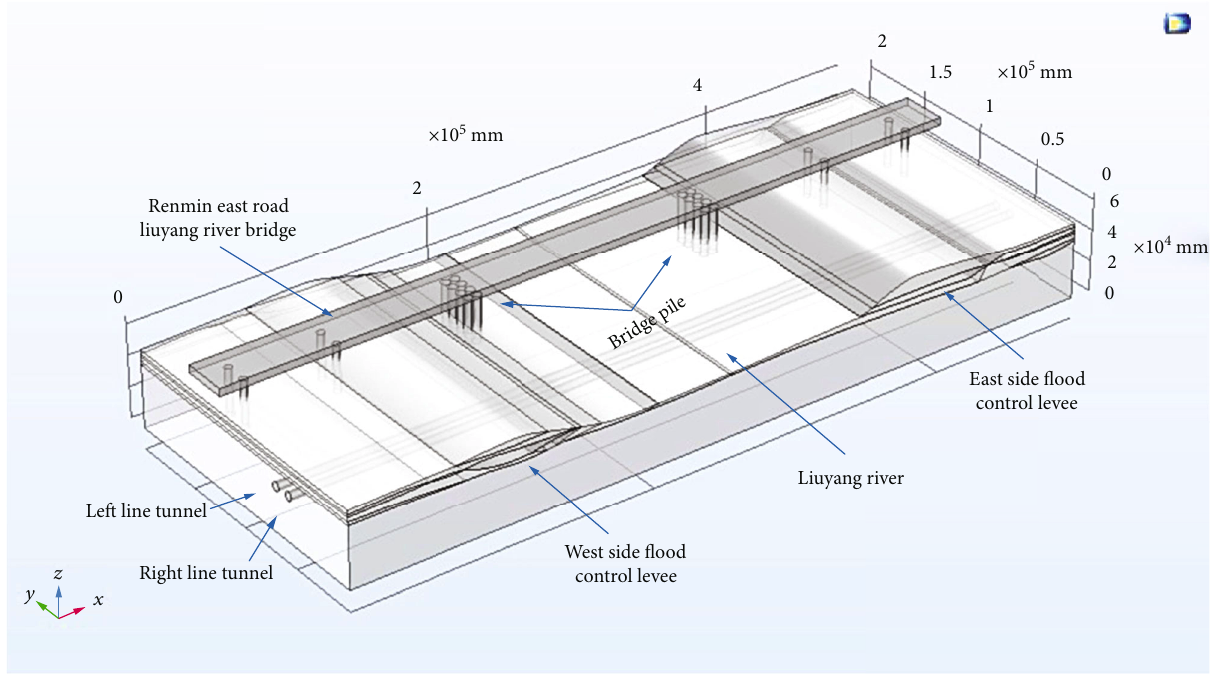
Figure 4: Numerical simulation geometry model diagram. Table 2: Material parameter setting